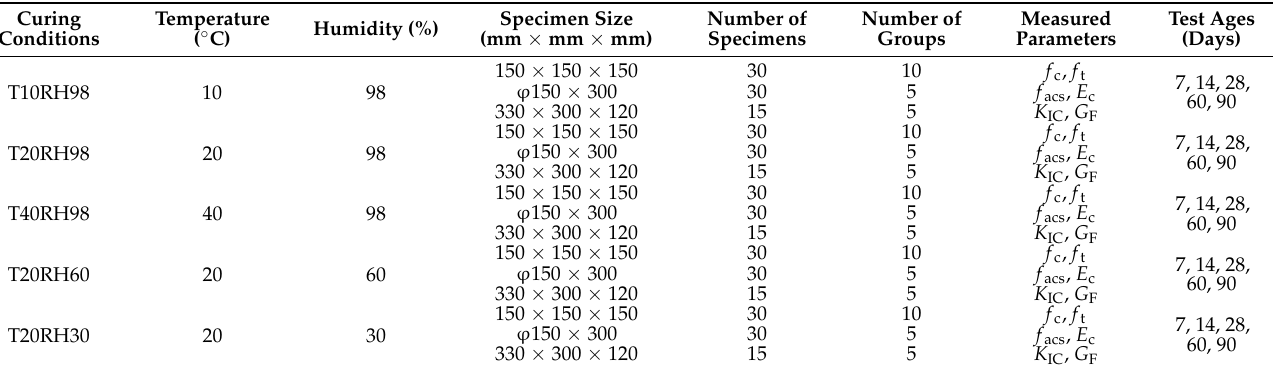
Table 3. Test scheme for the strength and fracture parameters of the environmental chamber-cured dam gallery